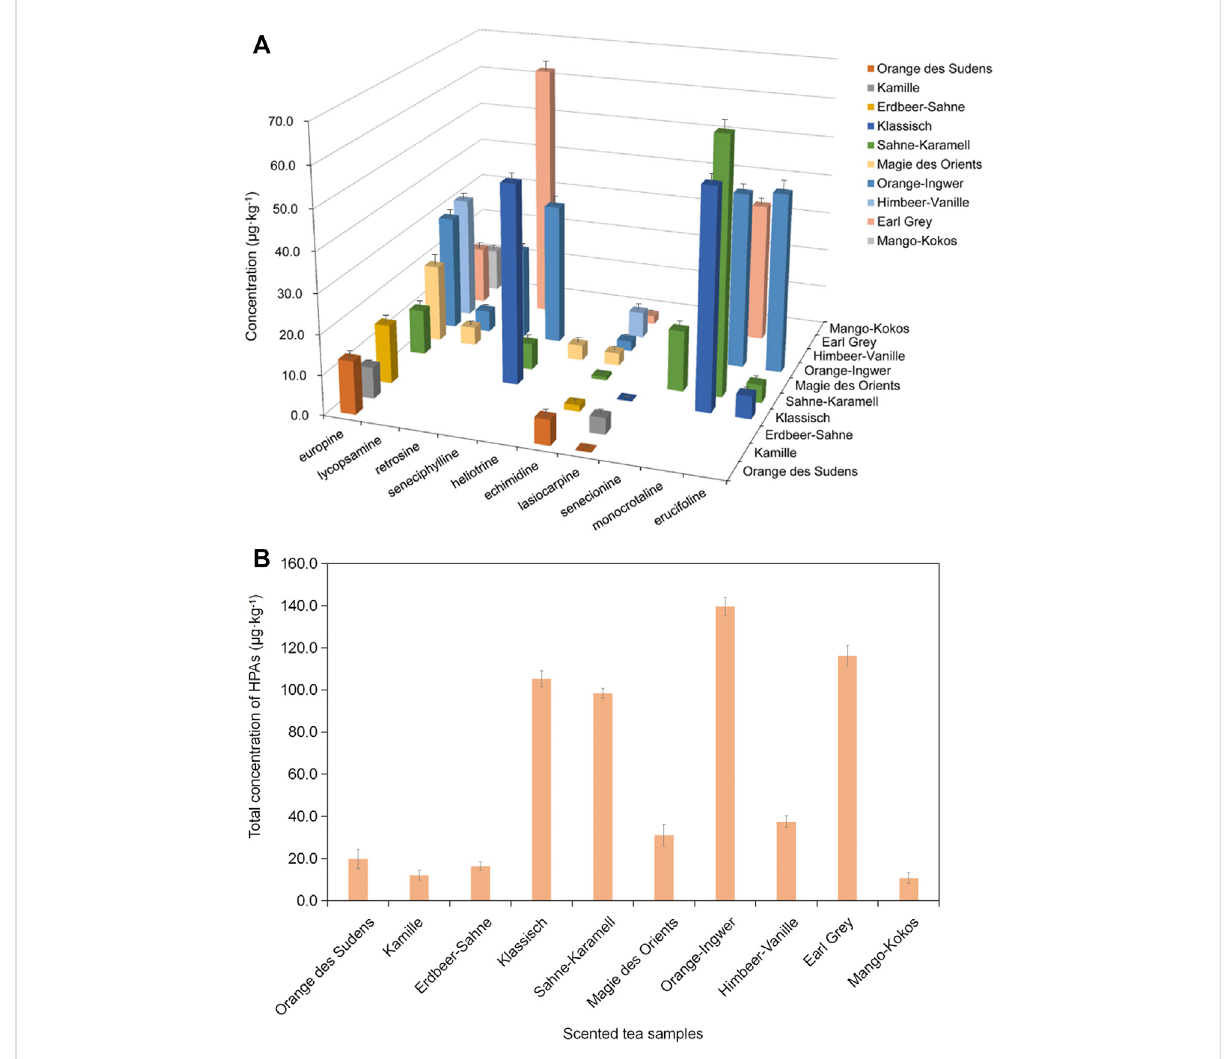
FIGURE 8 The concentration of HPAs in scented tea samples. (A) the concentration of a single analyte in positive tested samples; (B) the total concentration of HPAs in positive tested